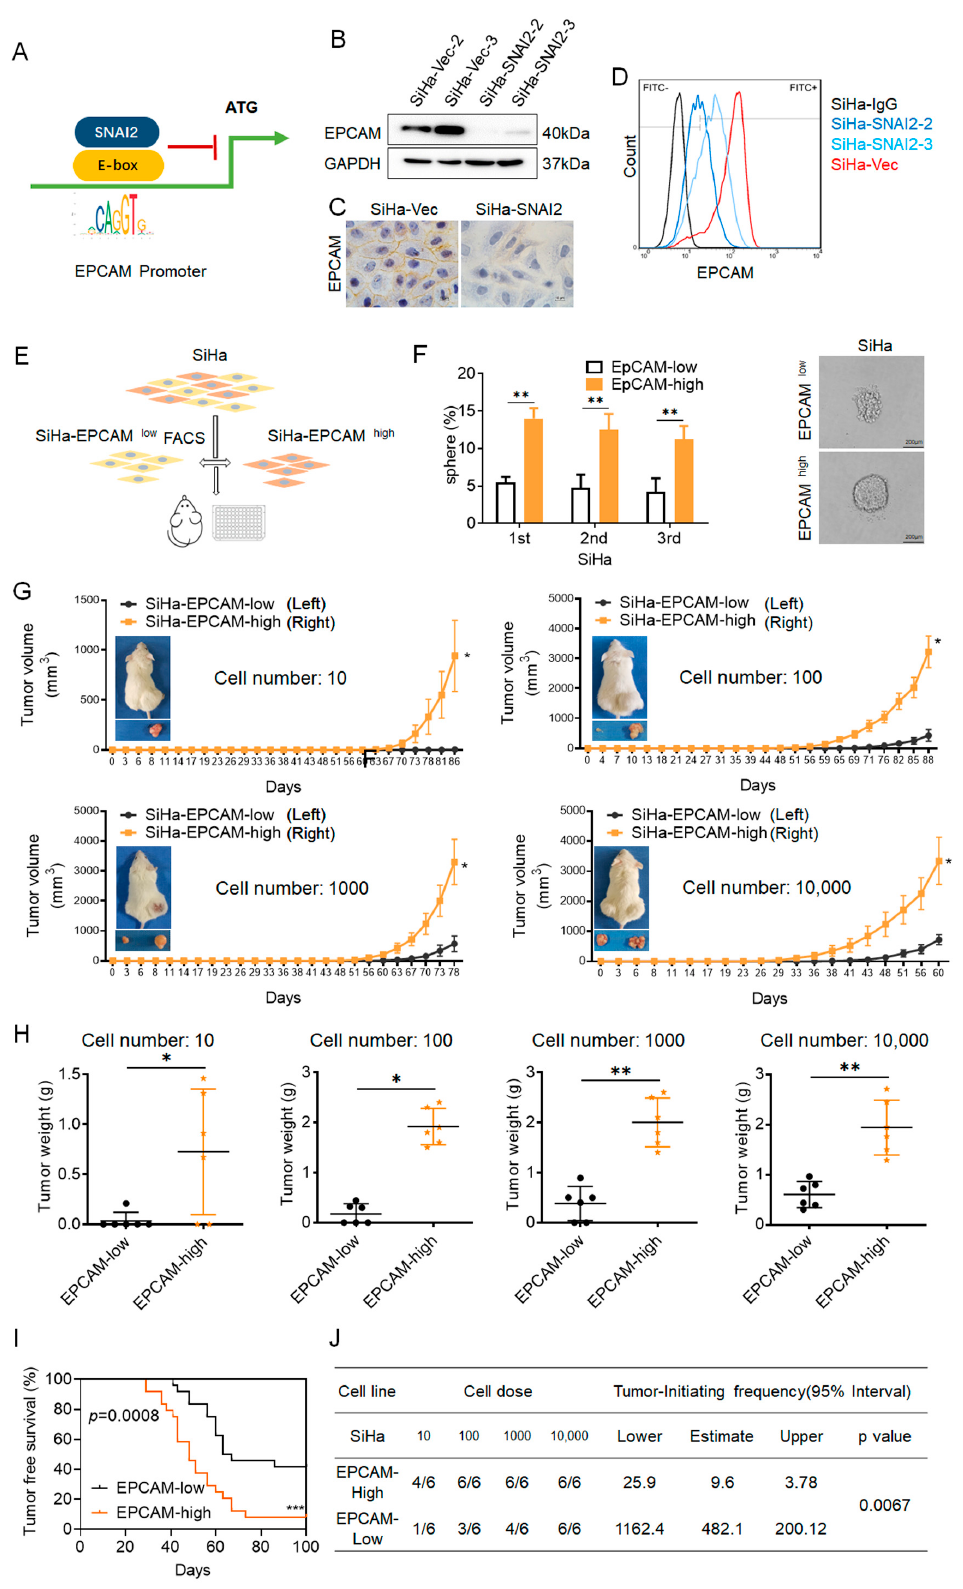
Figure 3. EPCAM high cells exhibited enhanced stem-like phenotype. ( A ). The transcription